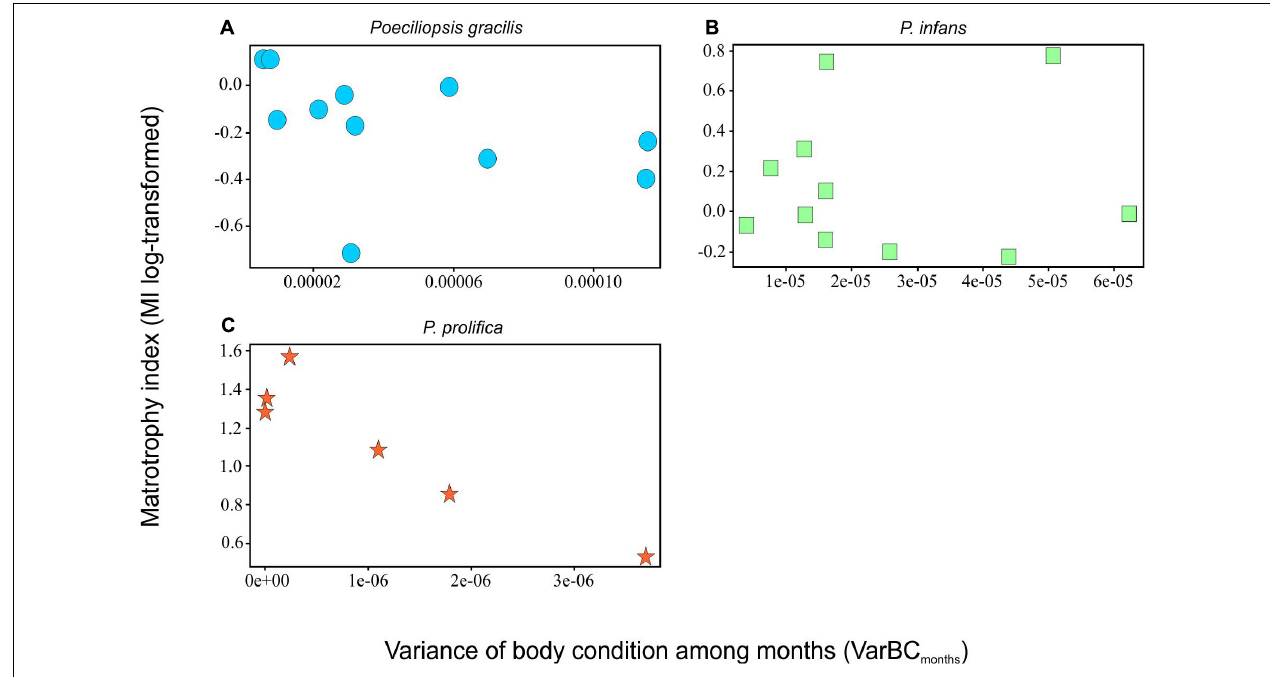
FIGURE 4 | Lack of association between the MI per population and the variance of body condition among months (VarBC months ) for 28 populations of three fish species from the genus Poeciliopsis . Each species is shown in a different panel because of substantial differences among species in the values of BC. Each symbol represents a different species as per ( Figures 1 , 2